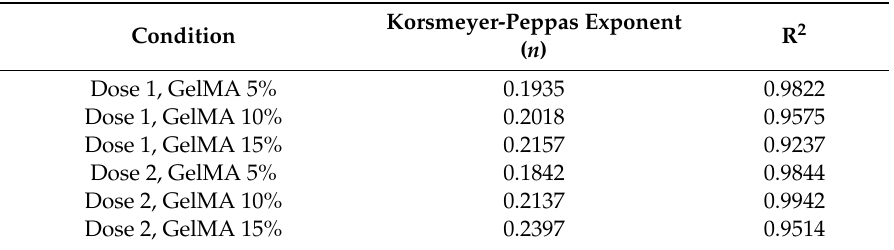
Table 2. Korsmeyer–Peppas model (log of % Abraxane ® released vs. log time). For each condition, R 2 values were determined, and the n value was used as an indication of the drug release mechanism. The model is valid and was applied only for the first 60% of